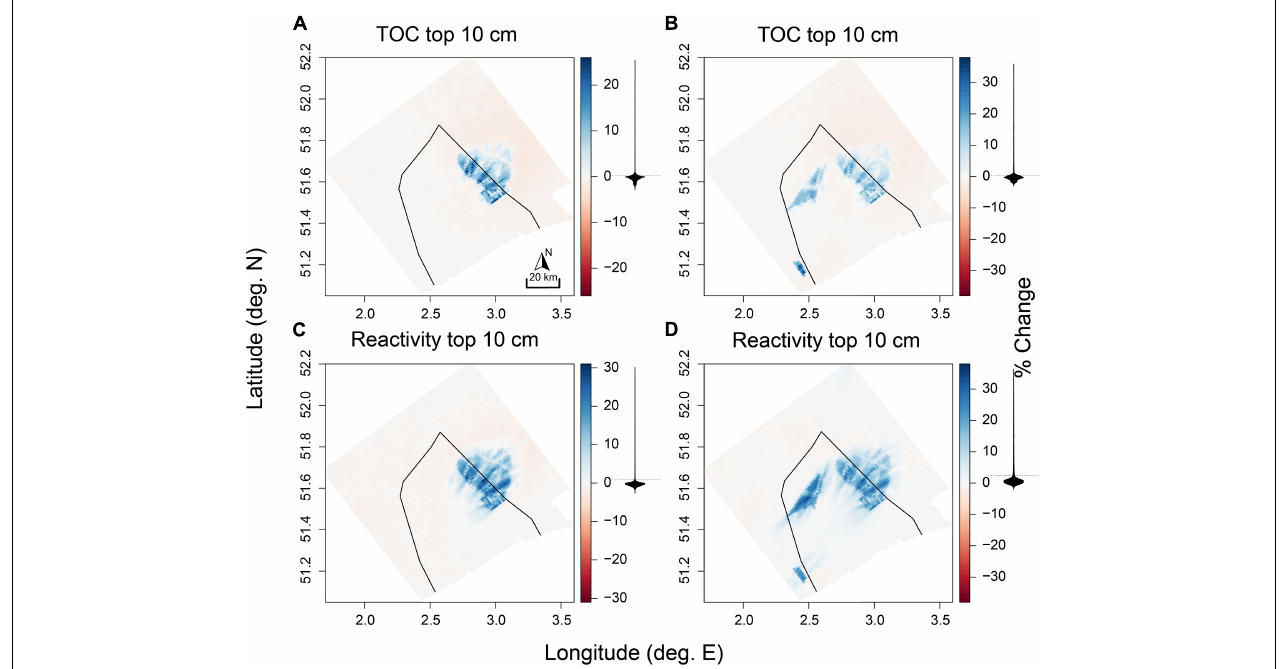
FIGURE 5 | Changes (%) to (A,B) total organic carbon (FDET + SDET) in the top 10 cm of the sediment and (C,D) reactivity of this organic material, for the “current” scenario (left column) and “future” scenario (right column). Belgian BPNS outlined in black. Density distributions of the values are represented as black shapes corresponding to the axis from the color